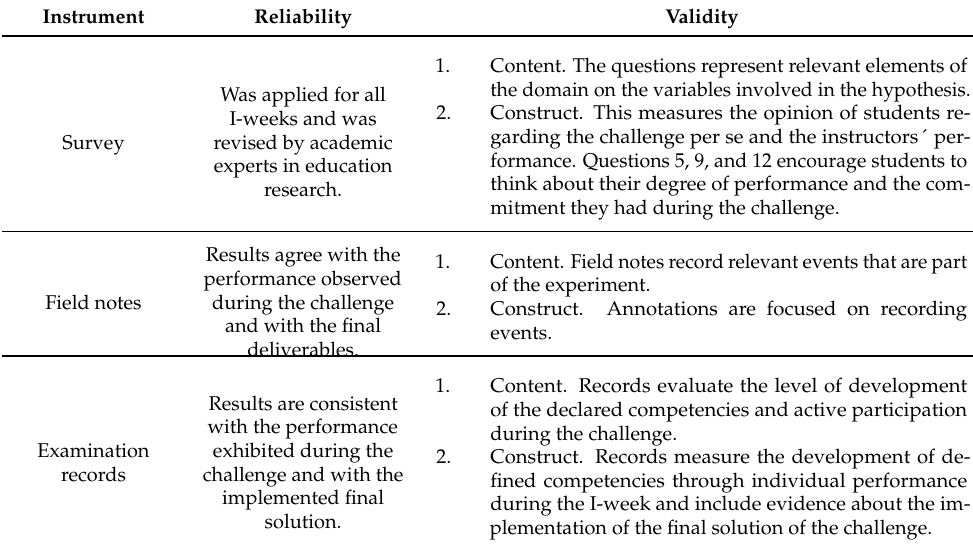
Table 3. Instruments—qualitative reliability and validity.